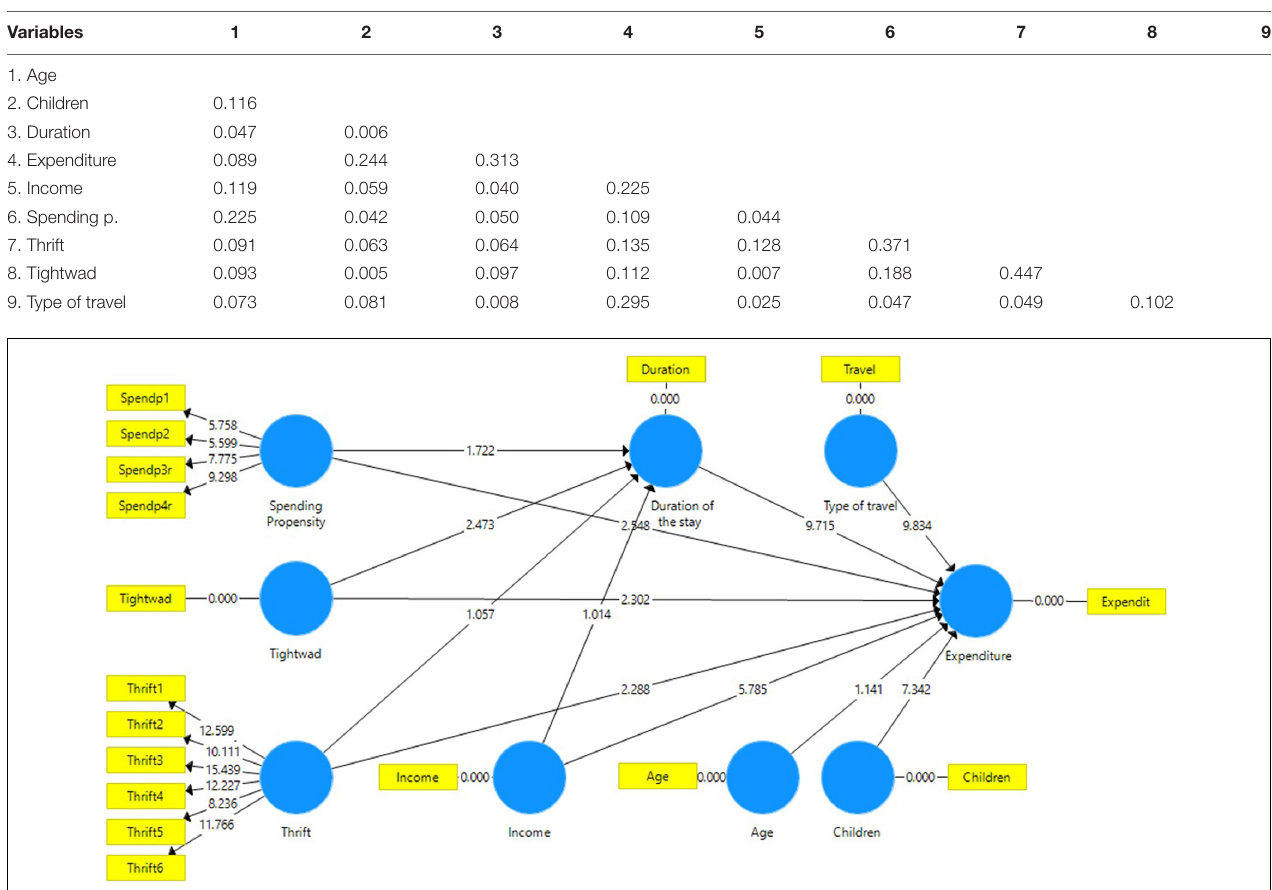
TABLE 4 | Assessment of discriminant validity using the heterotrait-monotrait ratio of correlations criterion. Variables 1